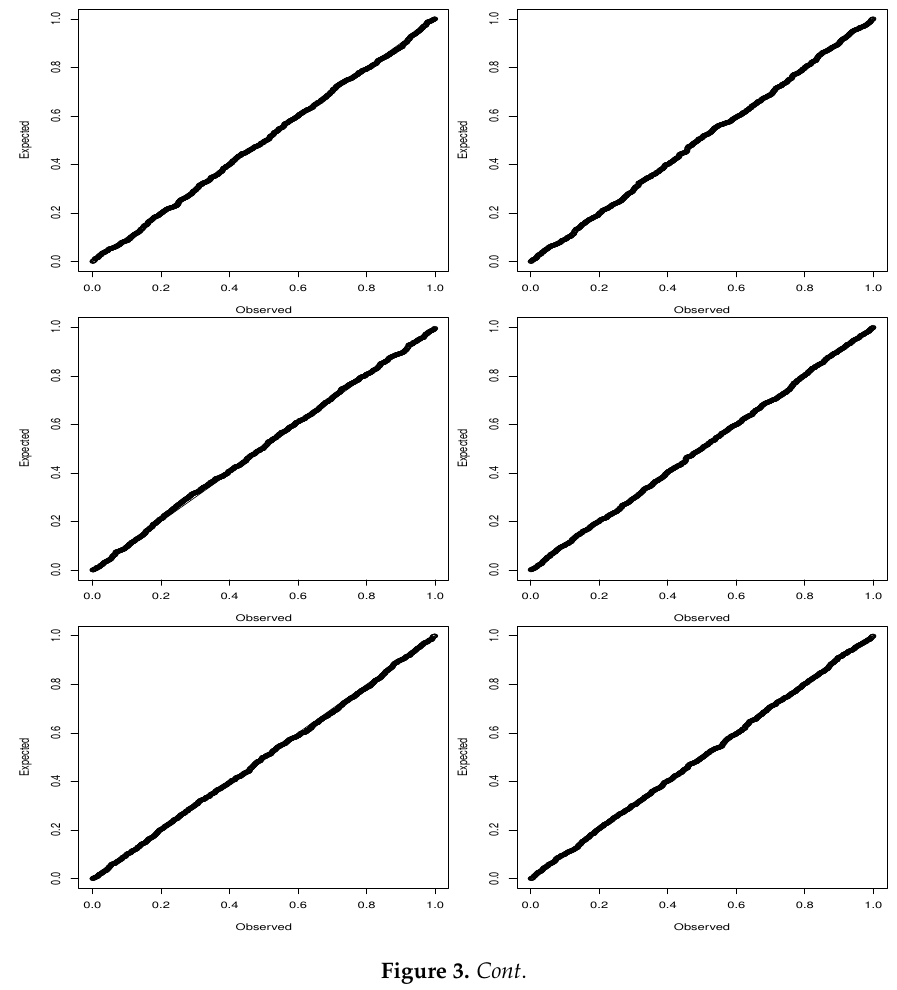
The P-P plots for the best fitting distribution for each of the seven cryptocurrencies are shown in Figure 3. For each cryptocurrency, the best fitting distribution captures the middle, lower and upper parts of the data well.